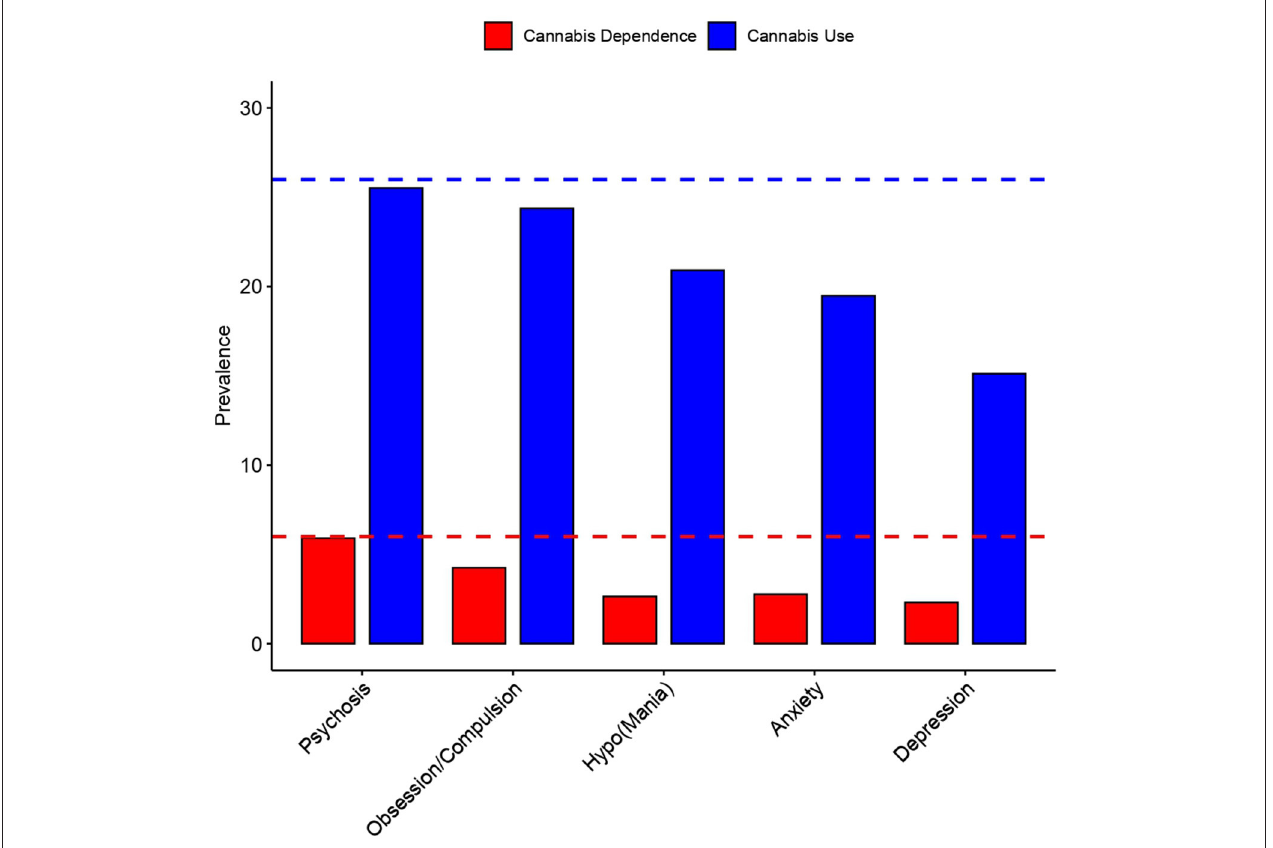
FIGURE 1 | Prevalence of Cannabis use and dependence in the population. Cannabis dependence is shown in red, and cannabis use in blue. The prevalence was divided in the psychiatric